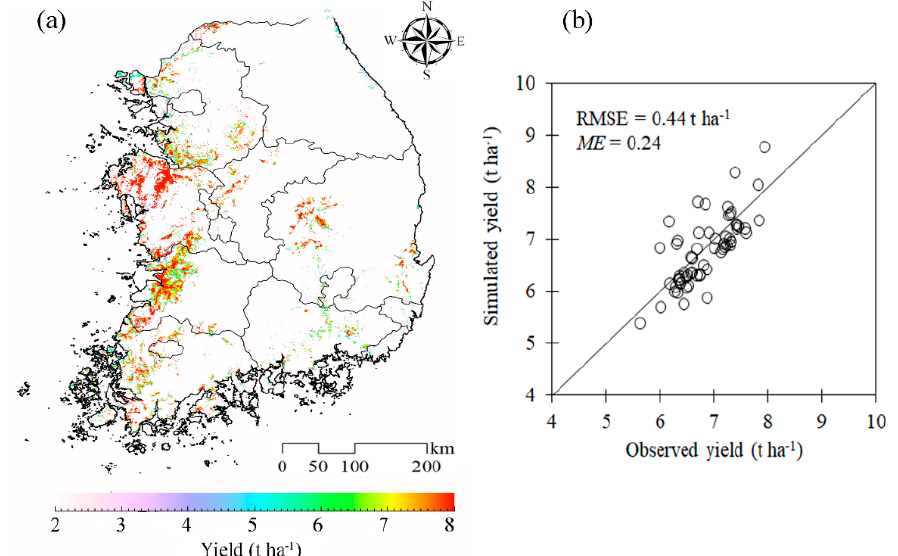
Figure 6. Simulated regional variation in rice yield in South Korea ( a ) and simulated mean rice yields in comparison with the observed mean rice yields in 62 administrative districts of the country, representing more than 5,000 ha of the paddy areas ( b ) in 2014. The yield data were simulated using Communication Ocean and Meteorological Satellite (COMS) imageries with a 500-m ground resolution.